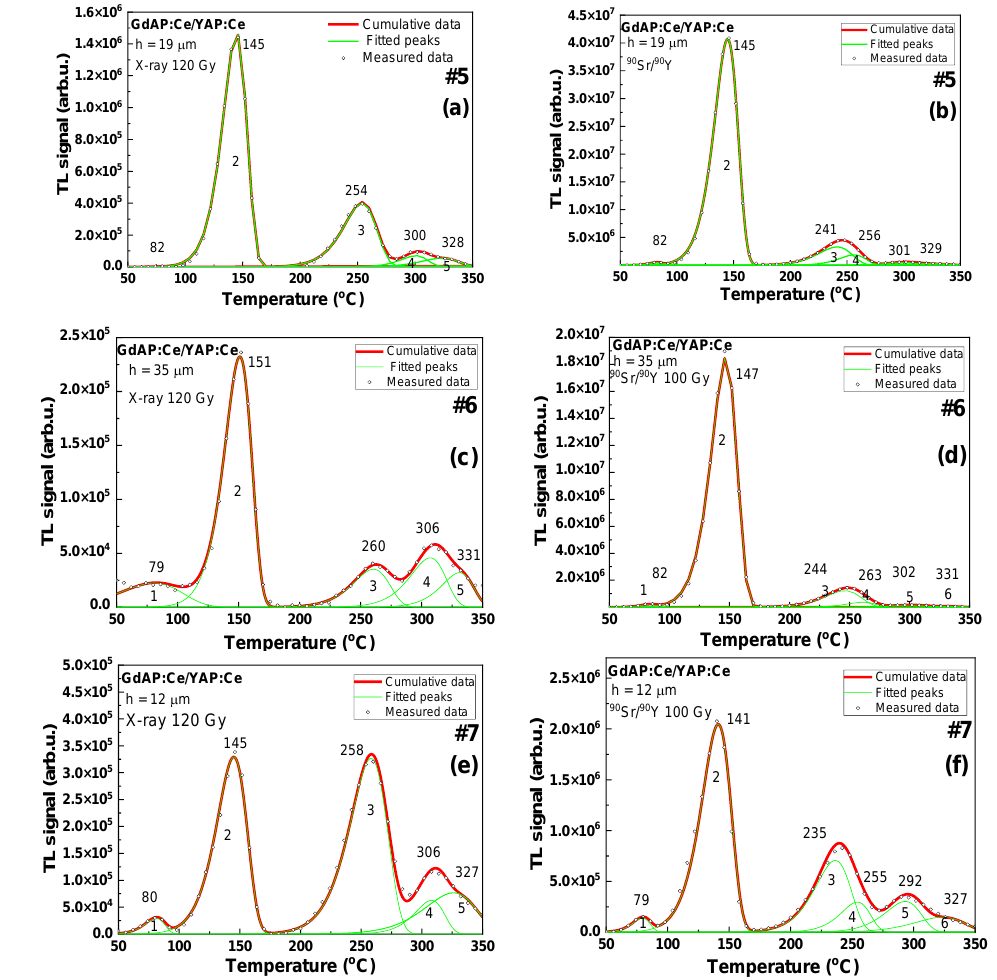
Figure 6. TL glow curves of samples #5, #6, and #7 ( a – f ) after excitation by X-rays and β -source. Table 4. The sets of peaks from sample #5, #6, and #7 curves after irradiation by X-rays or excitation by β -particles of 90 Sr/ 90 Y.